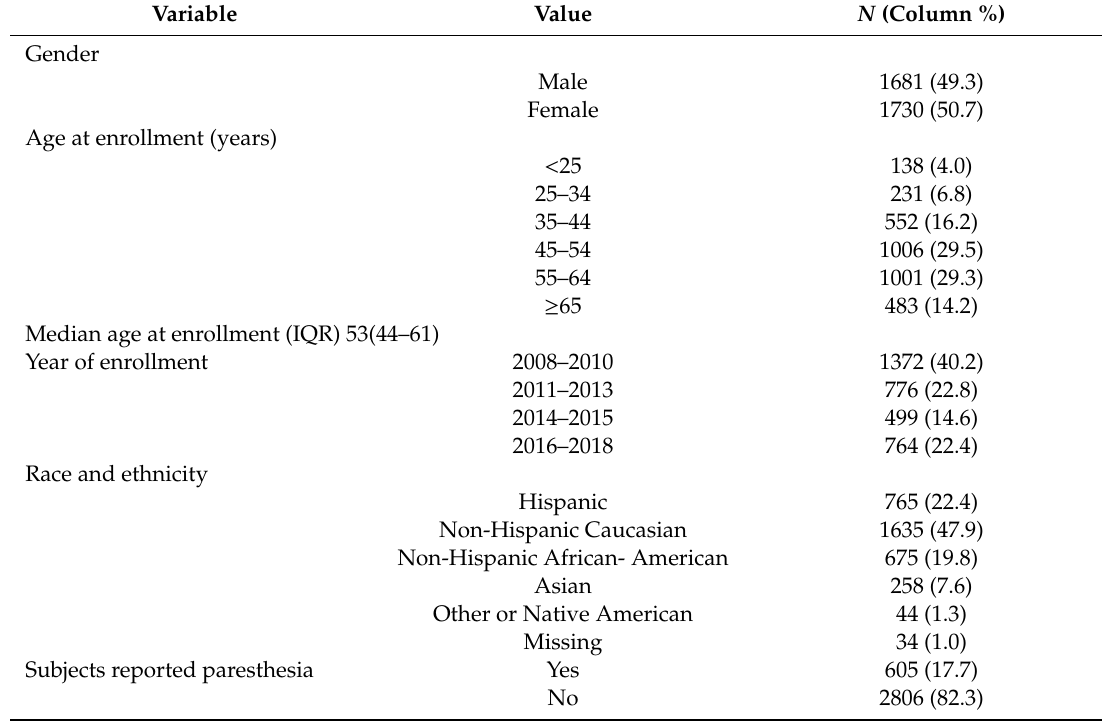
Table 2. Characteristics of subjects at the baseline visit ( n =